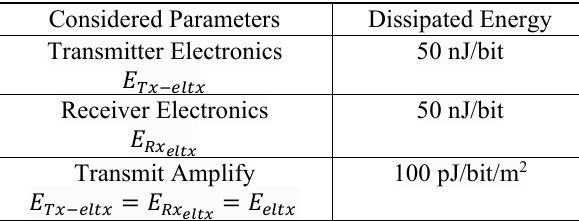
Table 1. Parameter used in LEACH Considered